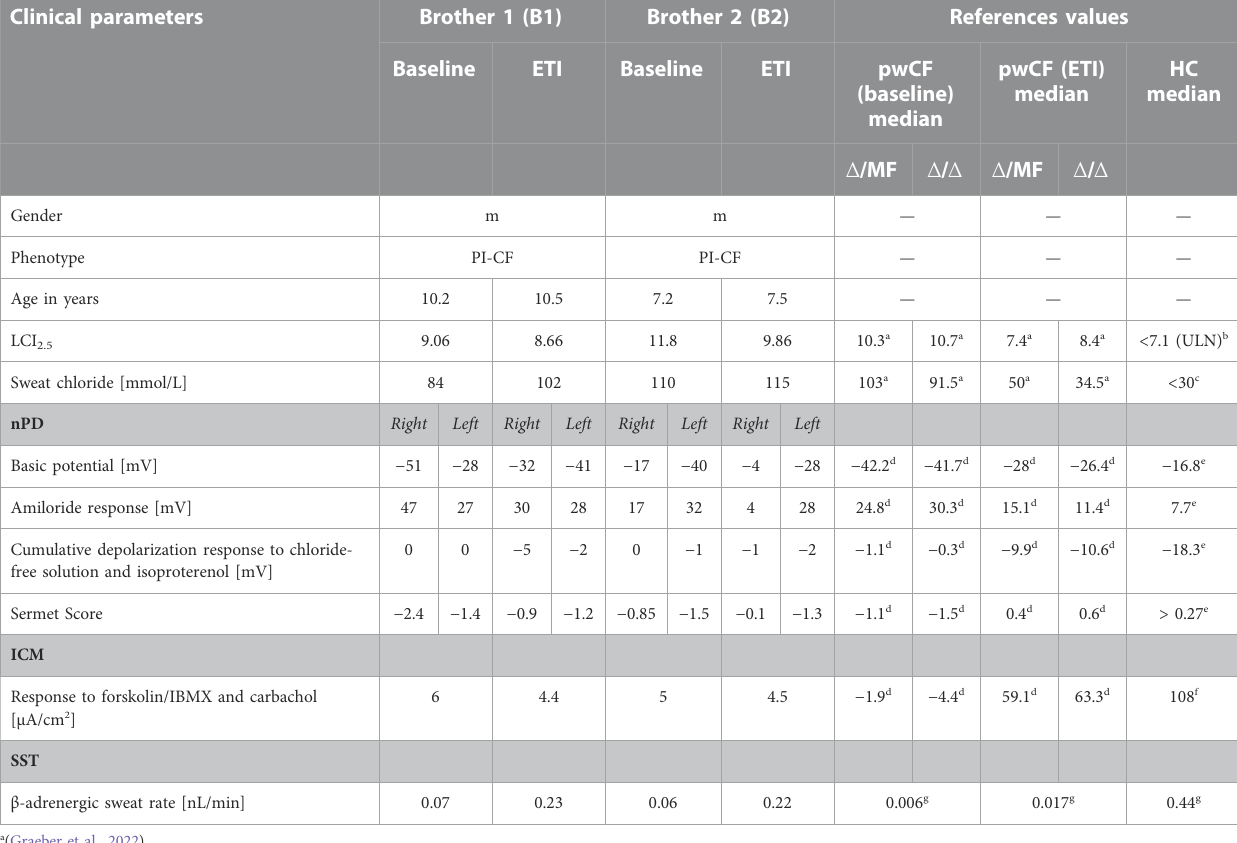
TABLE 1 Clinical and functional parameters of the two brothers before and under ETI therapy and reference values for pwCF with one ( Δ /MF) or two ( Δ / Δ ) p.Phe508del alleles without CFTR-modulator therapy (baseline) and after 3 months of ETI (ETI) and healthy controls (HC). Clinical parameters